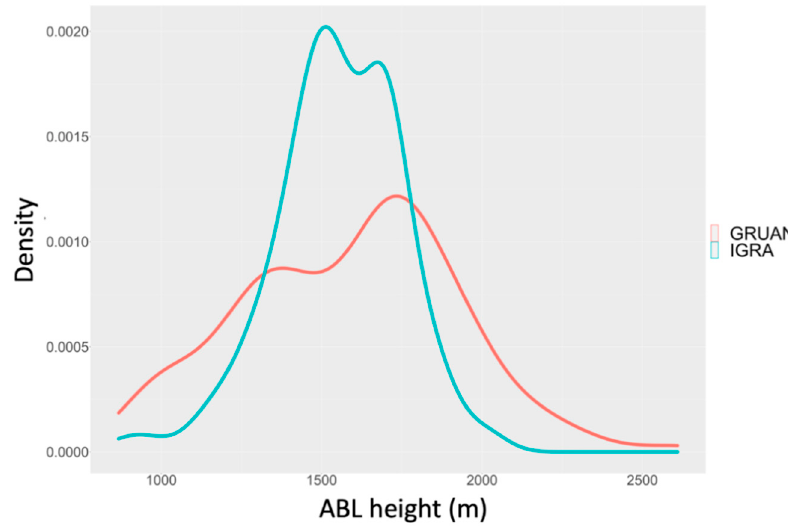
Figure 8. Density function of the ABL height estimates shown in Figure 7.